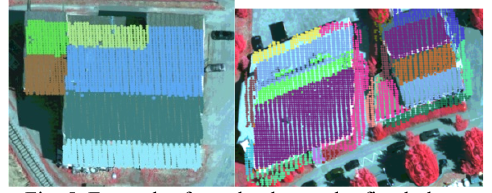
Fig. 5. Examples from the detected refined planes.